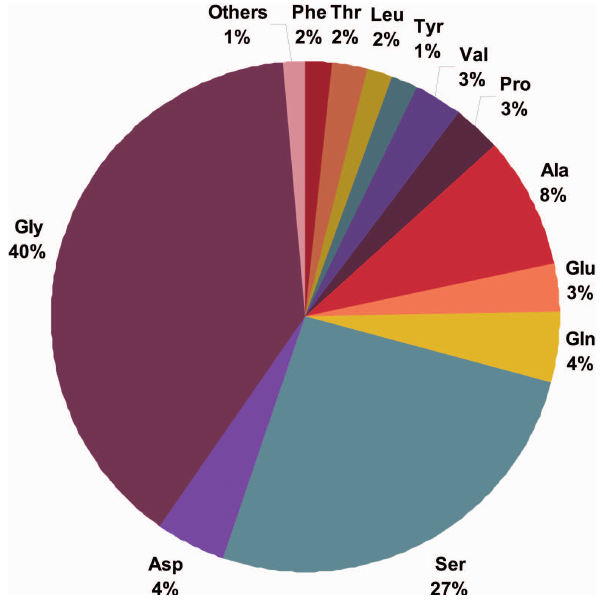
Fig. 2. Mean relative abundances of amino acids in total